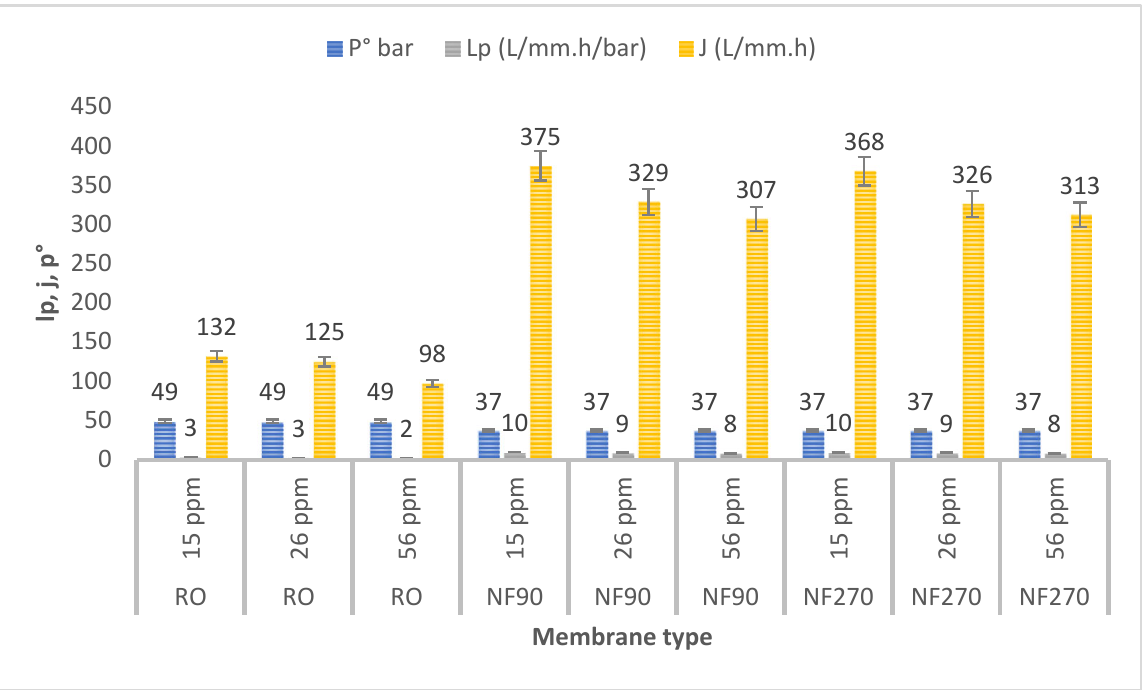
Figure 6. Permeability and permeate flow at constant pressure.